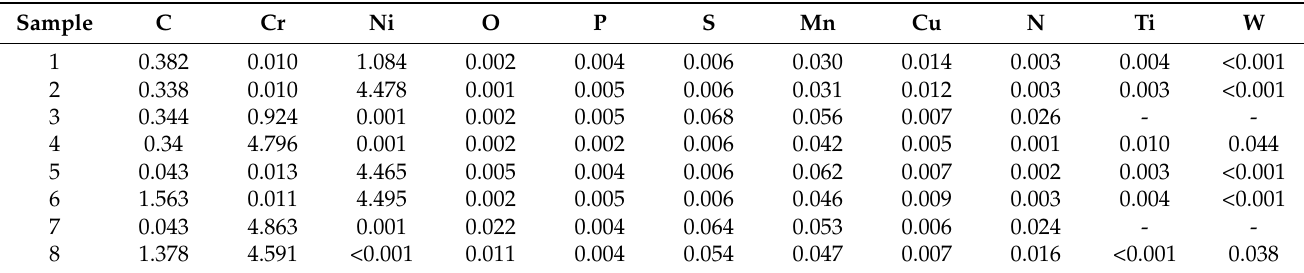
Table 1. Chemical composition of Fe–alloys